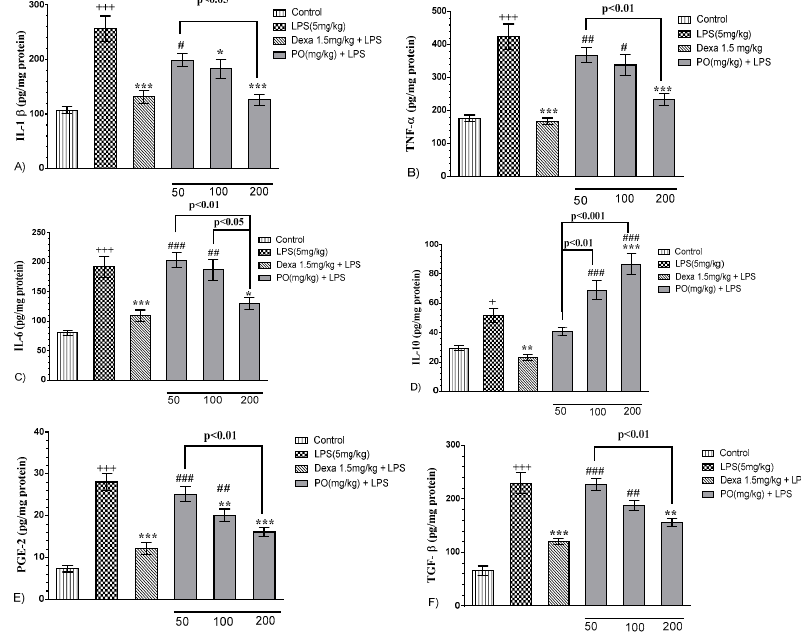
Figure 3. Effects of PO extract on inflammatory and anti-inflammatory biomarkers ( A ) interleukin (IL)-1 β , ( B ) TNF- α , ( C ) IL-6, ( D ) IL-10, ( E ) PGE 2 , and ( F ) TGF- β in BALF. Data were presented as mean ± SEM ( n = 7). + p ≤ 0.05 and +++ p ≤ 0.001 compared with the control group; * p ≤ 0.05, ** p ≤ 0.01, and *** p ≤ 0.001 compared with the LPS-induced group; and # p ≤ 0.05, ## p ≤ 0.01, and ### p ≤ 0.001 compared with the Dexa + LPS